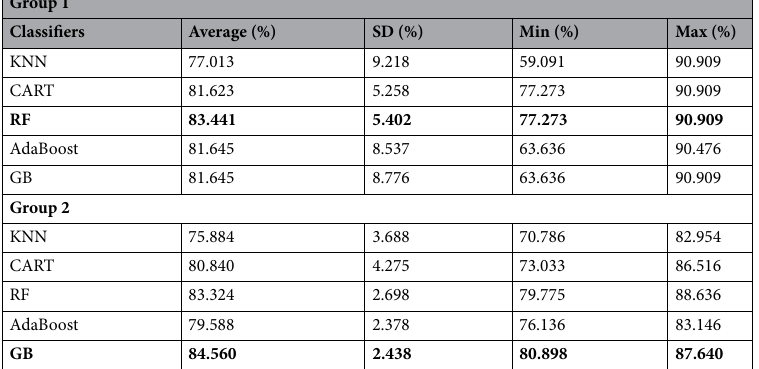
Table 1. Comparison of models by tenfold cross validation accuracy for the diagnosis of newborns. The data set was divided according to whether the patient files do not have text data (Group 1) or have text data (Group 2). The best model for each group is indicated by bold letters. The abbreviations refer to the ML algorithm used: KNN is the k-nearest neighbor, CART is the classification and regression trees, RF is the random forest, and GB is gradient